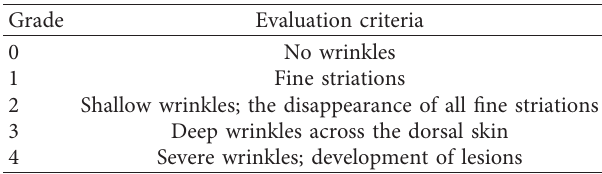
Table 1: Grading scales for wrinkle scoring of the UV-A-treated mice